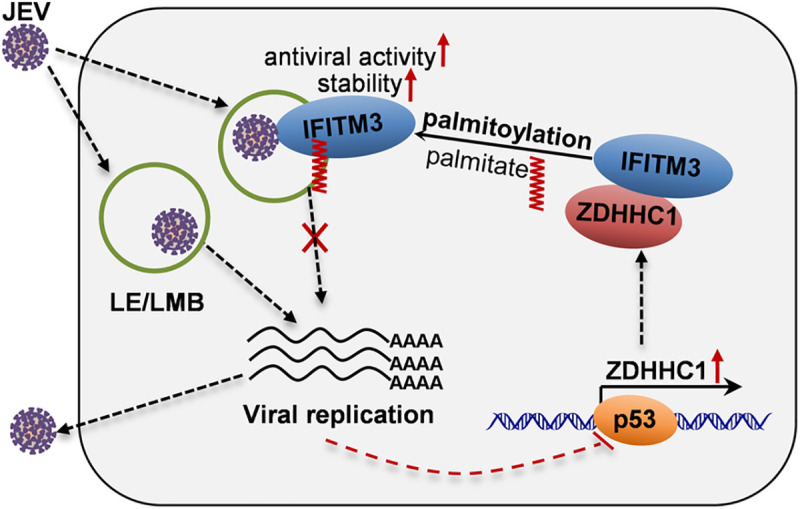
A proposed model for interaction of hsot p53-ZDHHC1-IFITM3 pathway and JEV infection.IFITM3 plays a critical role for restricting JEV infection in a palmitoylation dependent manner. p53 promotes IFITM3 protein palmitoylation and stability, which is mediated via transcriptionally upregulating ZDHHC1 expression to enhance IFITM3 palmitoylation, thus forming a cellular intrinsic anti-JEV pathway. However, JEV infection also effectively reduces p53 expression to antagonize p53-ZDHHC1-IFITM3 pathway for viral evasion.